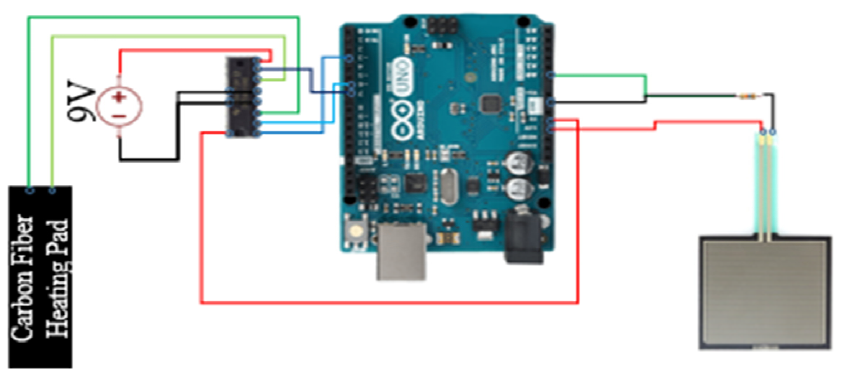
Figure 4. The architecture of the computation module.